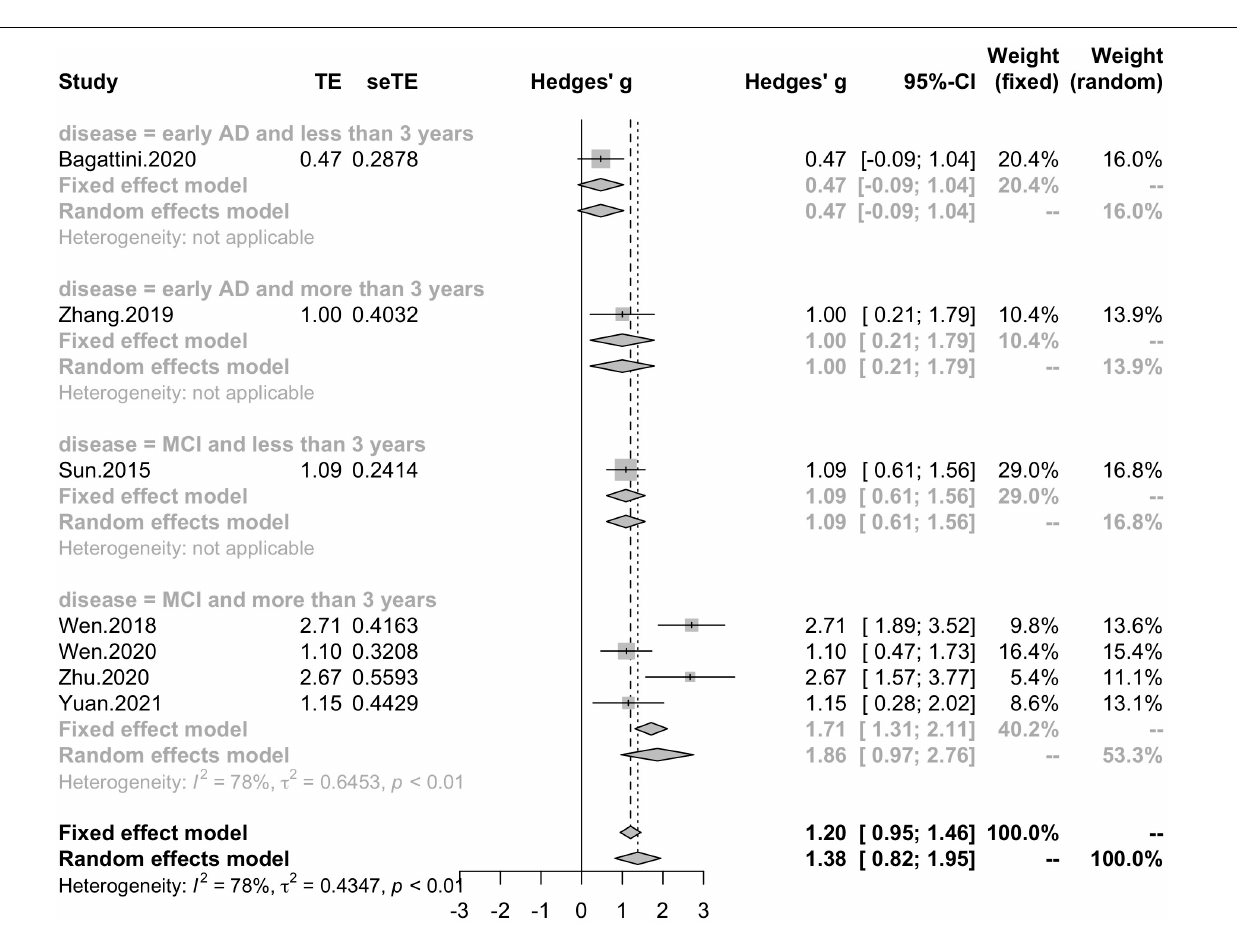
FIGURE 8 | Forest plot: mean differences in disease characteristic subgroup with 95%